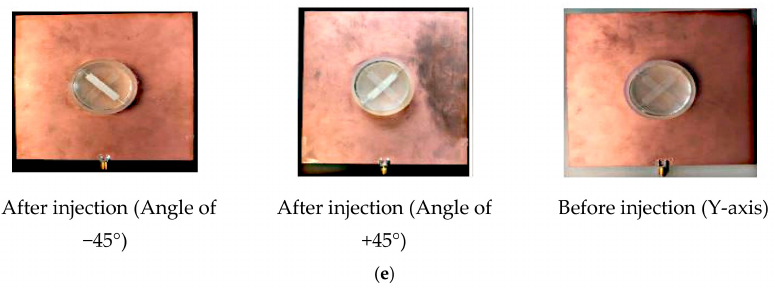
Figure 17. Design principles of the proposed DRA in [51]: ( a ) DRA without polarizer; ( b ) DRA with polarizer; ( c ) distribution of electric-field into DRA; ( d ) distribution of electric-field into DRA with polarizer; ( e ) working angle before and after the liquid-metal injection.